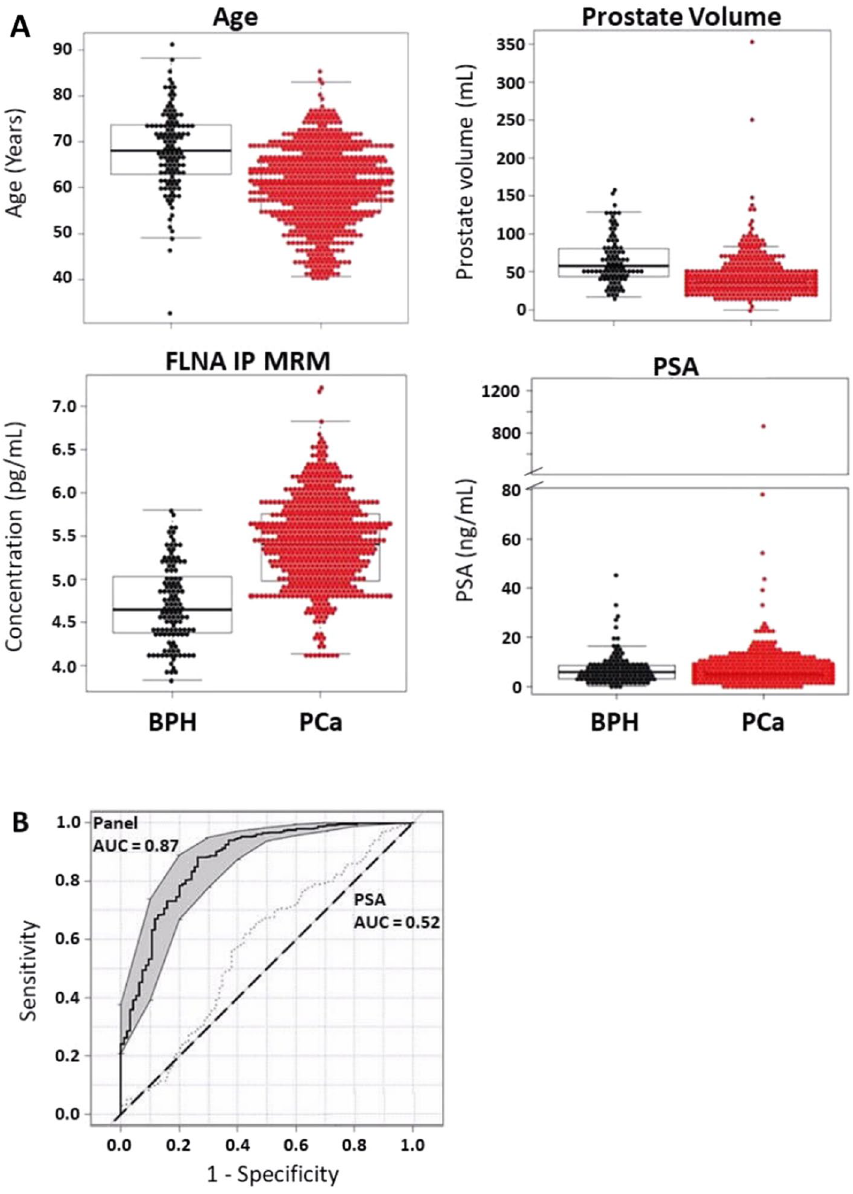
Figure 3. Prostate Cancer Biomarker Panel Differentiates Lower Urinary Tract Symptoms/Benign Prostate Hyperplasia (LUTS/BPH) from Prostate Cancer (PCa) in Patients who have had multiple biopsies. ( A ) Beeswarm and boxplot graphs showing median, interquartile range and distribution of age (years), prostate volume (mL), serum FLNA concentrations (pg/mL), and serum PSA concentrations (ng/mL) from patients who have had multiple biopsies. Data represents n = 94 LUTS/BPH and n = 477 PCa. ( B ) Receiver operator characteristics (ROC) curve for prostate cancer biomarker panel demonstrates better performance in differentiating patients with LUTS/BPH from PCa compared to PSA alone. Area under the curve (AUC) for the panel is 0.87 versus PSA alone 0.57. Shaded grey regions indicate standard